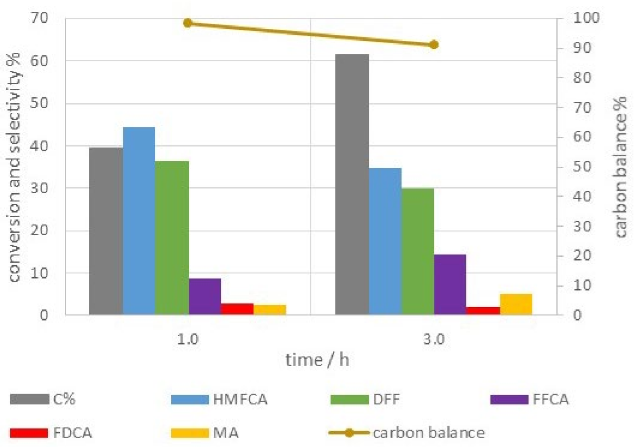
Figure 8. Conversion of HMF and selectivity of products in the absence of a catalyst as a function of reaction time. HMF 0.55 M in CH 3 CN, TBHP/HMF 14, 60 ◦